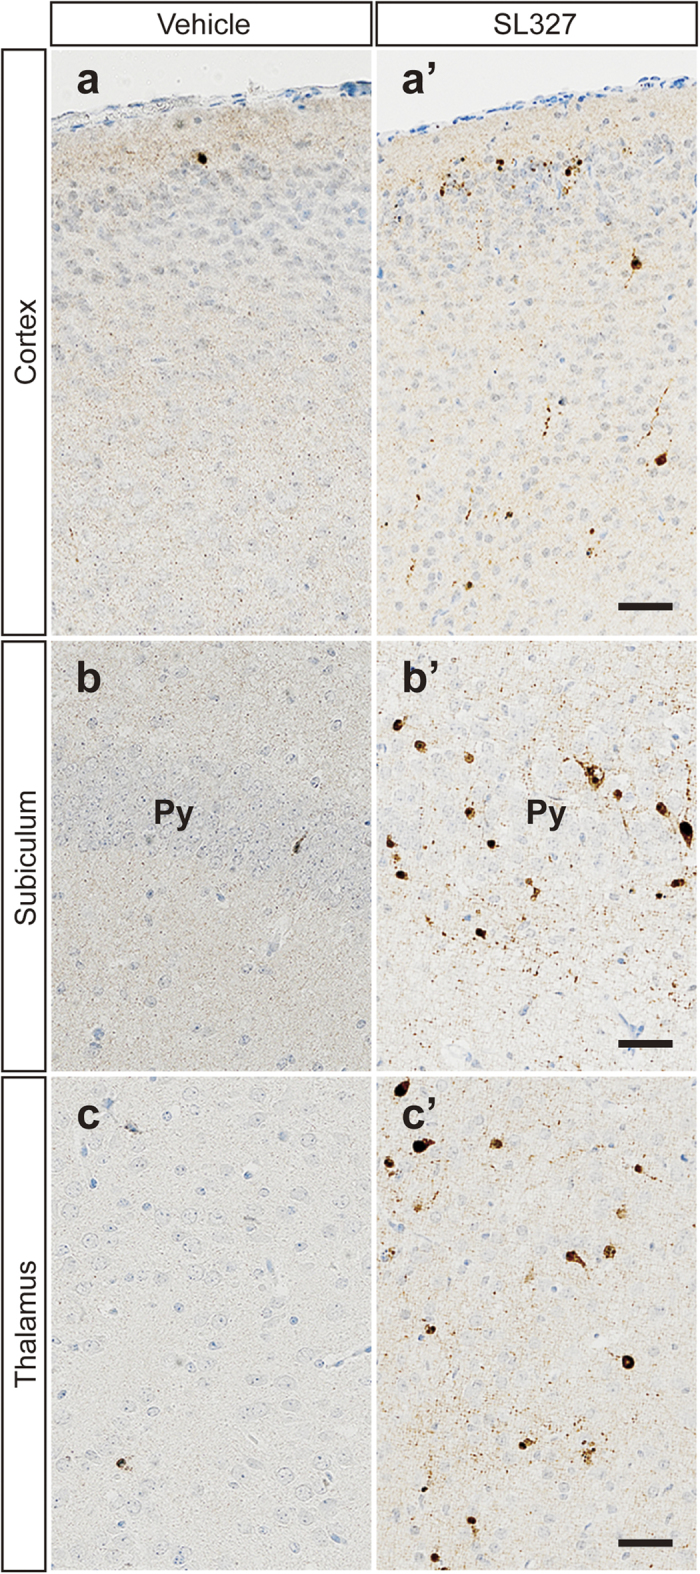
SL327 induced apoptosis in several regions of the brain at P6. Representative high-power images of the brains from mice treated with vehicle (a–c) or SL327 (a’–c’). (a,a’) cortex, (b, b’) subiculum, (c, c’) thalamus. Scale bars: 50 μm.